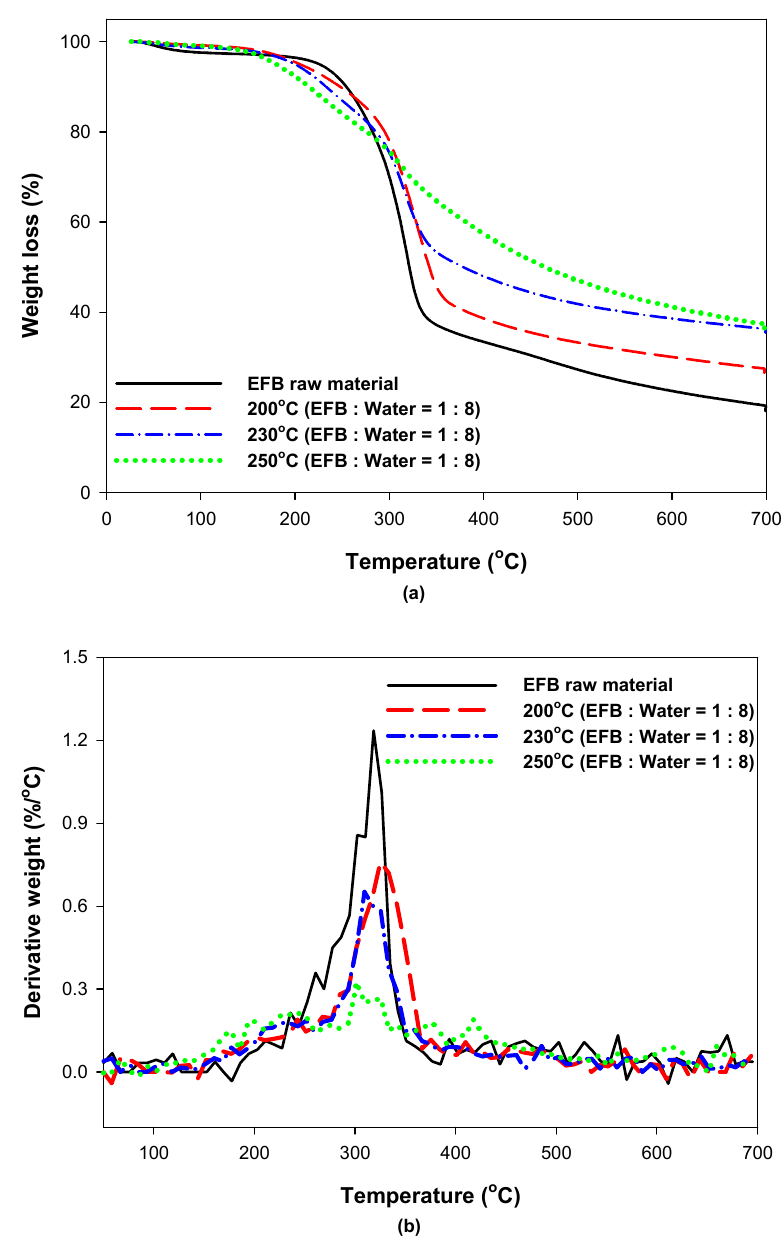
Figure 7. ( a ) Thermogravimetric analysis (TGA) and ( b ) derivative thermogravimetry (DTG) curves of EFB according to reaction temperature (EFB:water =